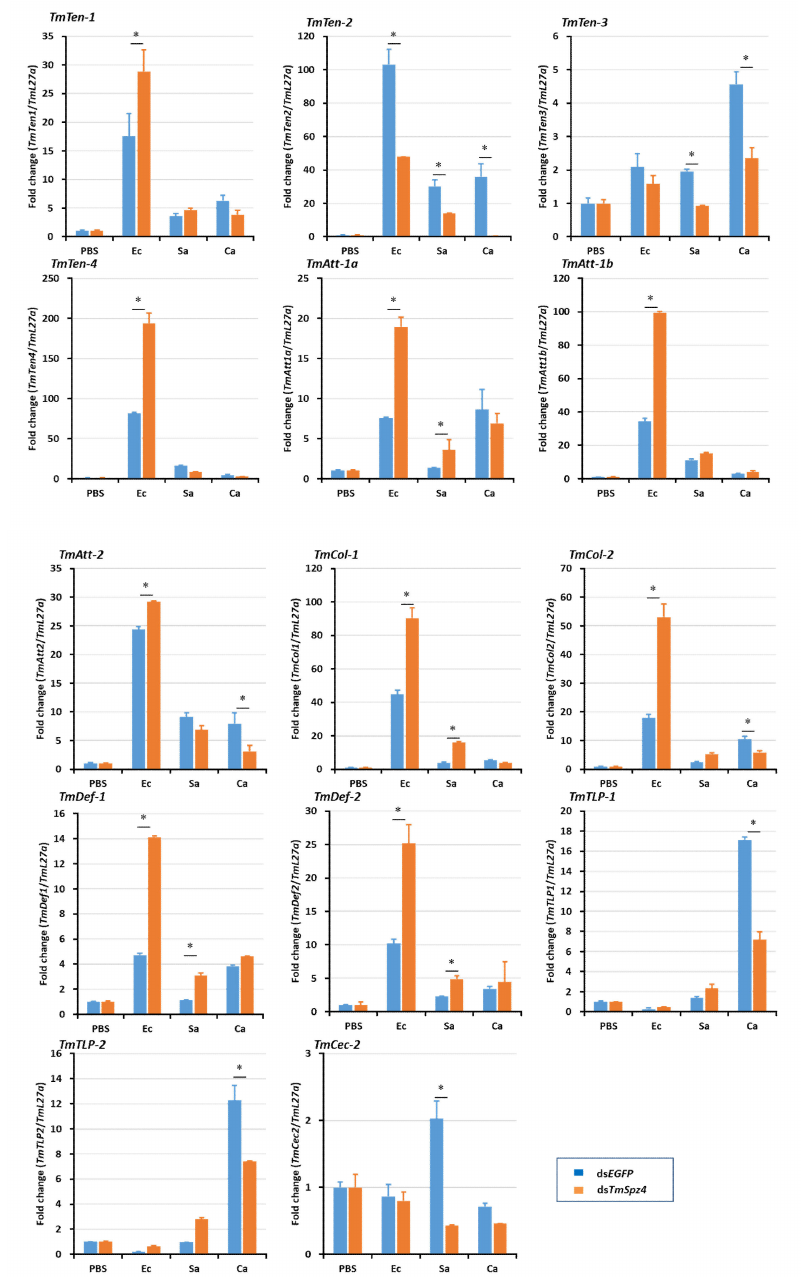
Figure 5. Antimicrobial peptide (AMP) induction patterns in hemocytes of TmSpz4 -silenced larvae. AMP gene expression levels in the hemocytes of TmSpz4 -knock-down T. molitor larvae were assessed after injection with E. coli (Ec), S. aureus (Sa), or C. albicans (Ca). PBS was injected as a control 5 days post- TmSpz4 silencing. At 24 h post-microbial challenge, the expression levels of several AMP genes, including those of TmTen-1 , TmTen-2 , TmTen-3 , TmTen-4 , TmAtt-1a , TmAtt-1b , TmAtt-2 , TmDef-1 , TmDef-2 , TmCol-1 , TmCol-2 , TmCec-2 , TmTLP-1 , and TmTLP-2 , were measured by qRT-PCR. ds EGFP was injected as a negative control, and TmL27a expression was measured as an internal control. All experiments were performed in triplicate. Asterisks indicate significant di ff erences between ds TmSpz4- and ds EGFP- treated groups when compared by Student’s t -test ( p <